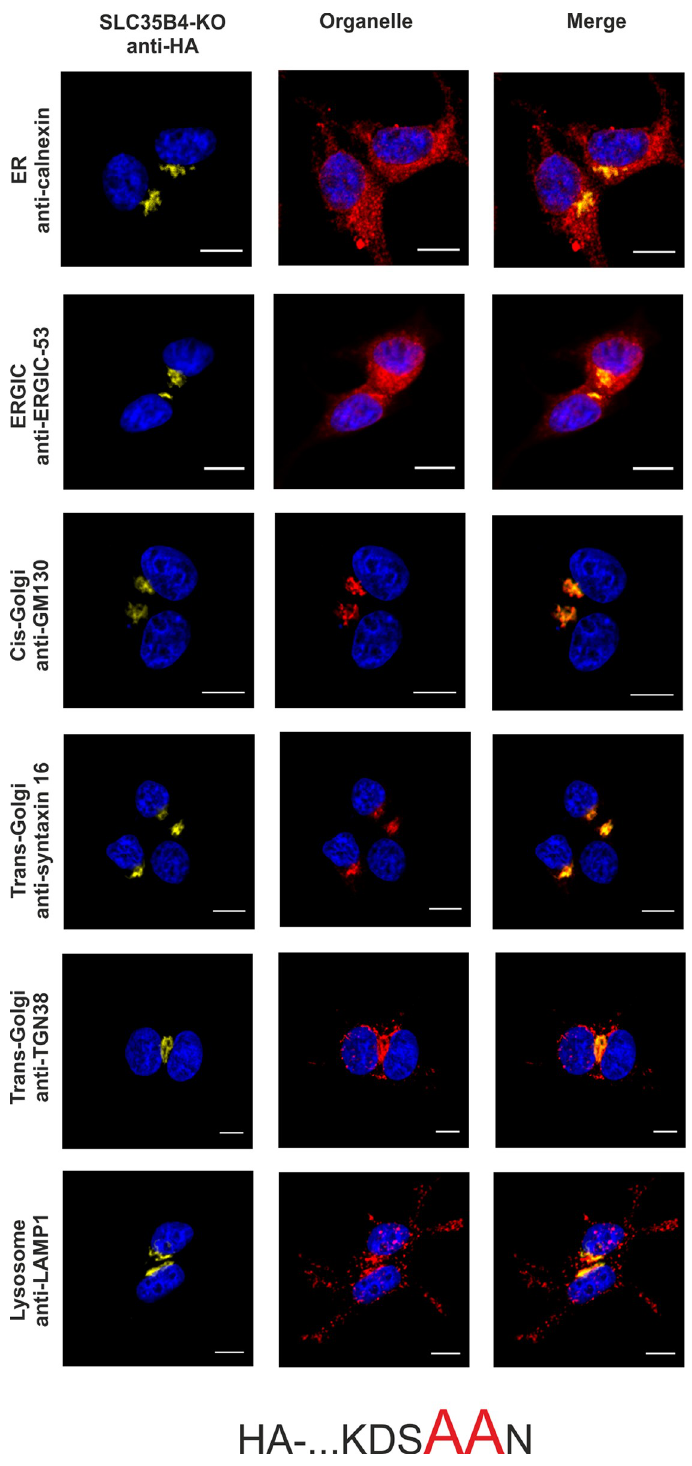
Fig 9. Subcellular localization of HA- ... KDSAAN, human SLC35B4 K329AK330A with HA-epitope at the N- terminus in the knock-out HepG2 cells. Stably transfected cells, lacking functional SLC35B4 gene (SLC35B4-KO), overexpressing SLC35B4 variants, were subjected to indirect immunofluorescent staining with anti-HA (green) and anti-organelle markers (Table 3) (red) antibodies. Cell nuclei were counterstained with DAPI. Scale bar 10 μ m.